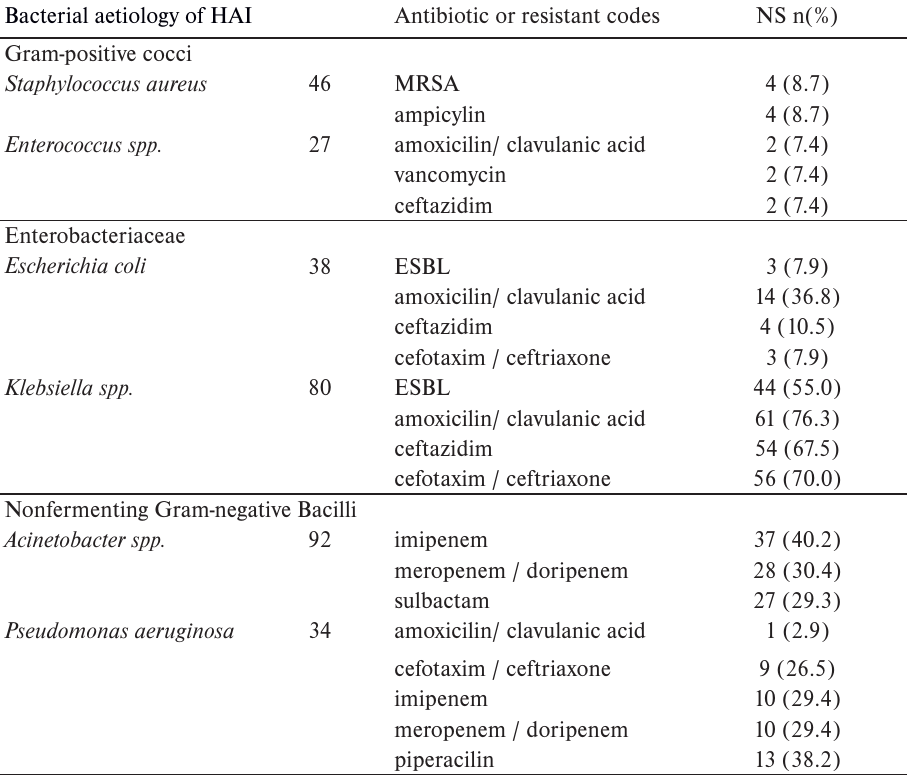
Table 4. Antimicrobial resistance in microorganisms isolated from HAI (data presented only for species with number of isolated